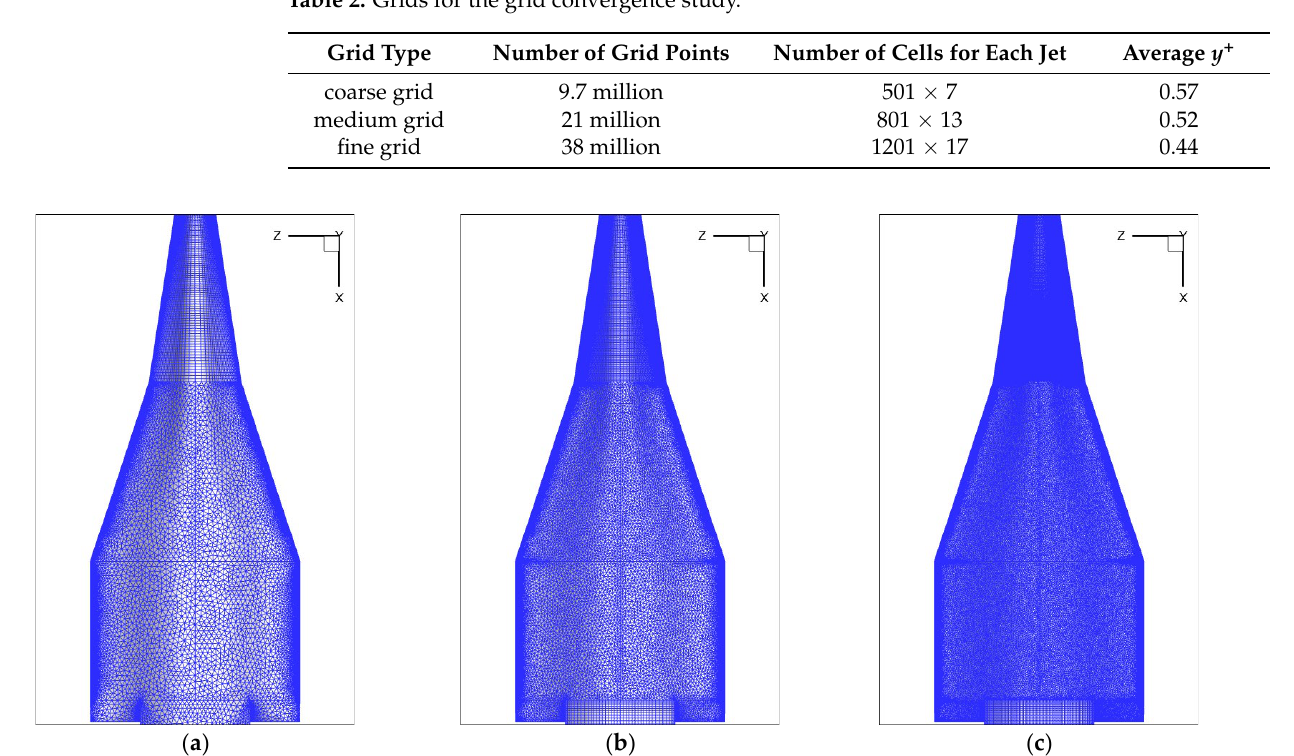
Figure 7. Grids for the grid convergence study. ( a ) Coarse grid; ( b ) Medium grid; ( c ) Fine grid.